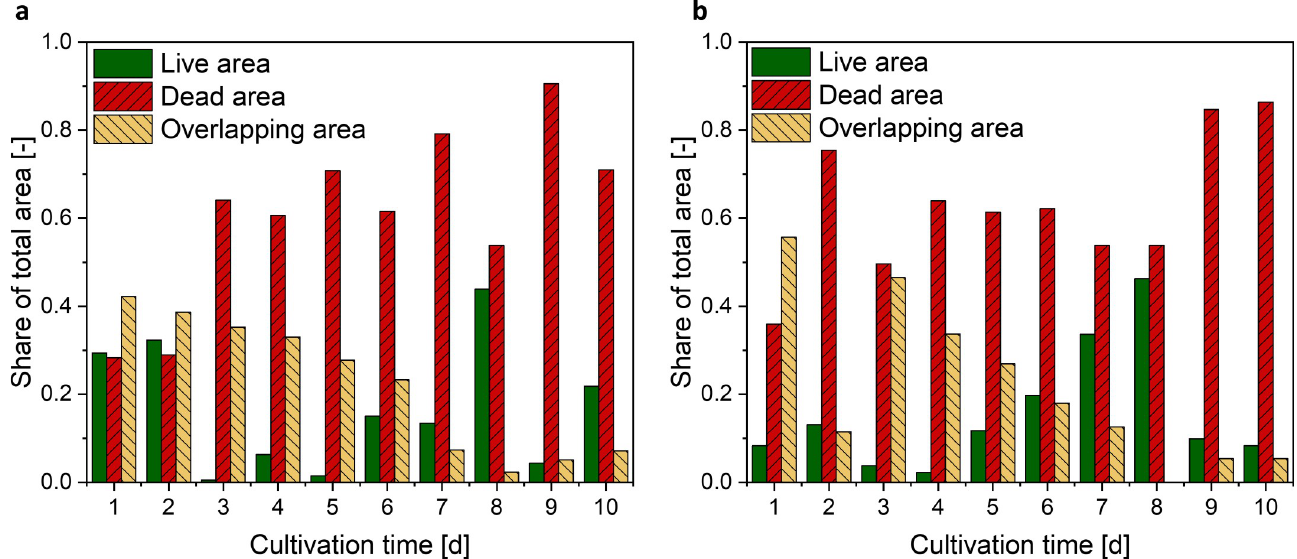
Fig 5. Share of live, dead, and overlapping areas of investigated pellets from cultivations (a) without and (b) with glass beads resulting from sliced and stained pellets and CLSM